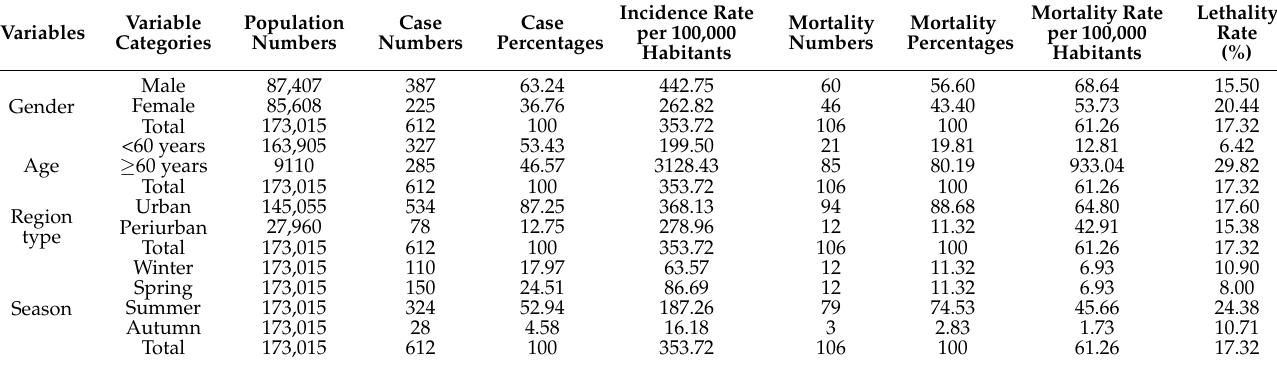
Table 1. Epidemiological indictors, sociodemographic and environmental conditions interactions (N = 612).